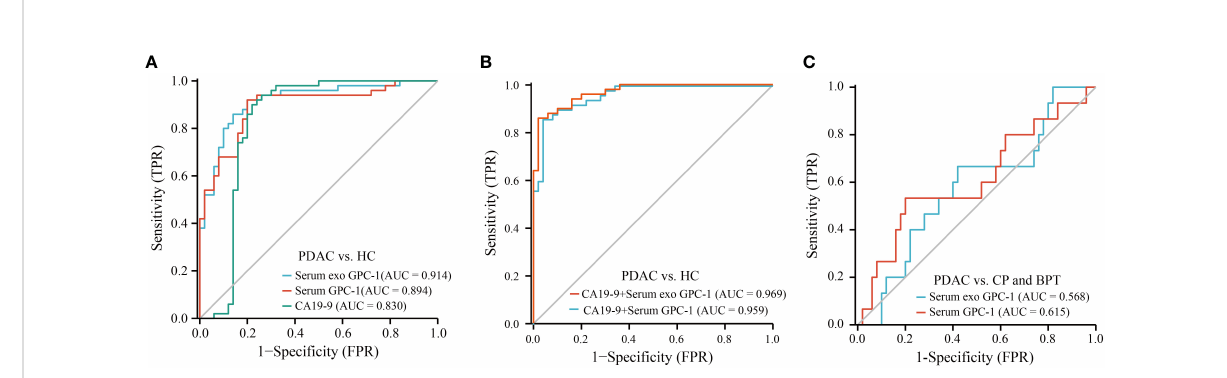
FIGURE 3 ROC curves for GPC-1 and CA19-9 in the diagnosis of early-stage PDAC. (A) ROC curve analyses of serum exosomal GPC-1, serum GPC-1, and CA19-9 as parameters to discriminate PDAC patients from HCs. (B) Combinations of serum exosomal GPC-1 and CA19-9 and serum GPC-1 and CA19-9 resulted in higher AUC values to distinguish patients with PDAC from HCs. (C) ROC curve for serum exosomal GPC-1and serum GPC-1 in patients with PDAC vs. CP and BPT. ROC, receiver operating characteristic; AUC, area under the receiver operating characteristic curve; PDAC, pancreatic ductal carcinoma; HCs, healthy controls; CP, chronic pancreatitis; BPT, benign pancreatic